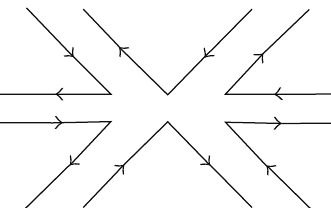
Figure 7: New vertex for an operator insertion of Tr (cid:2)Φ k (cid:3) with k (cid:6)